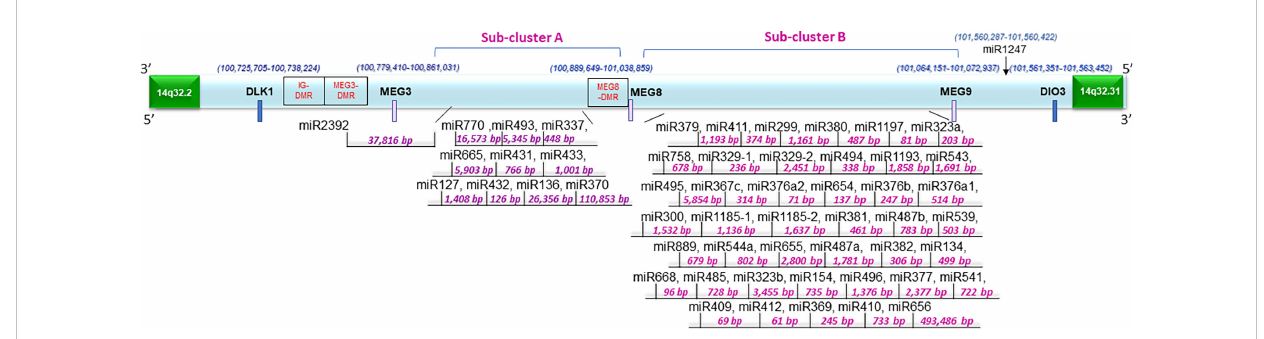
FIGURE 1 Schematic representation of the 14q32 miRNA cluster and surrounding region. Fifty-four miRNAs are located at the region depicted in two physically distinct subclusters. There are differentially methylated regions at this locus annotated as IG-DMR, MEG3-DMR, and MEG8-DMR. The distances between miRNAs were determined based on data derived from the UCSC genome browser (Dec. 2013 (GRCh38/hg38))